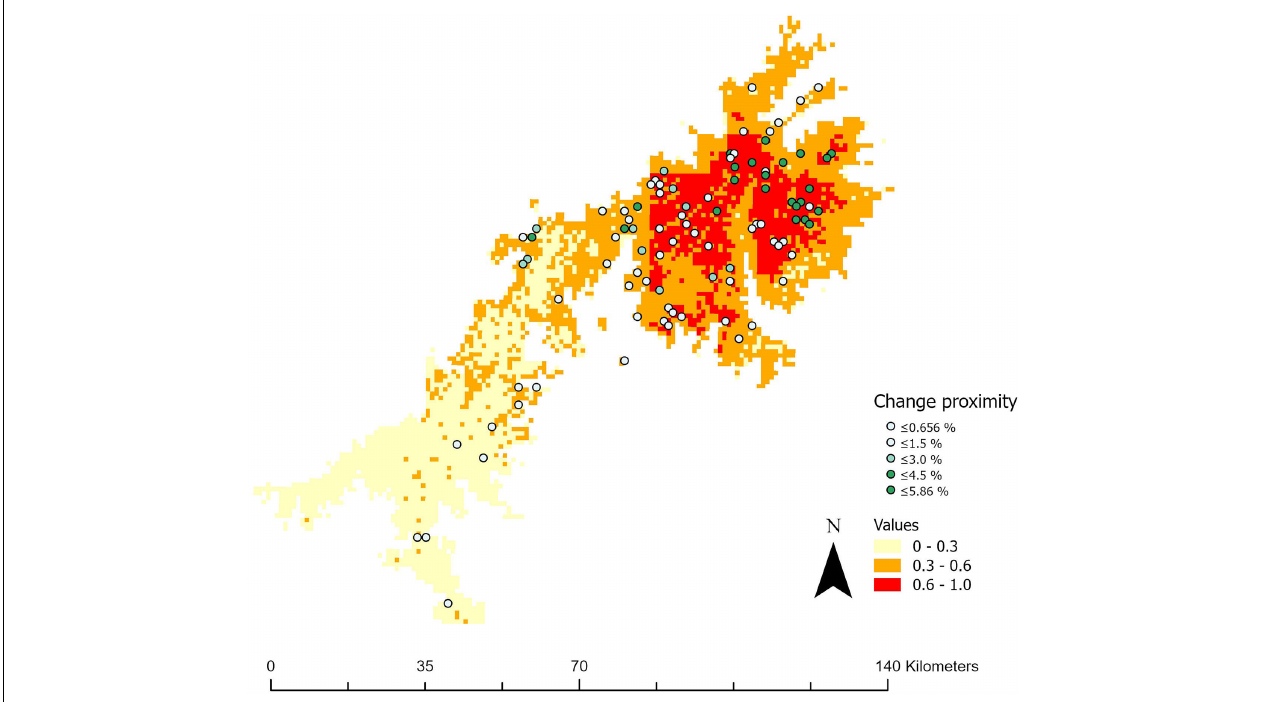
FIGURE 5 | Landscape proximity between present and suitable habitats for Walia ibex. The raster colors indicate the present-day proximity values. The dots represent the centroid of each suitable habitat patch. The color of the dots show how much the proximity value in each suitable patch would change (in percent) in the Simen mountain according to the prediction model Simen future corrected for slope showed in Figure 2 lower right.